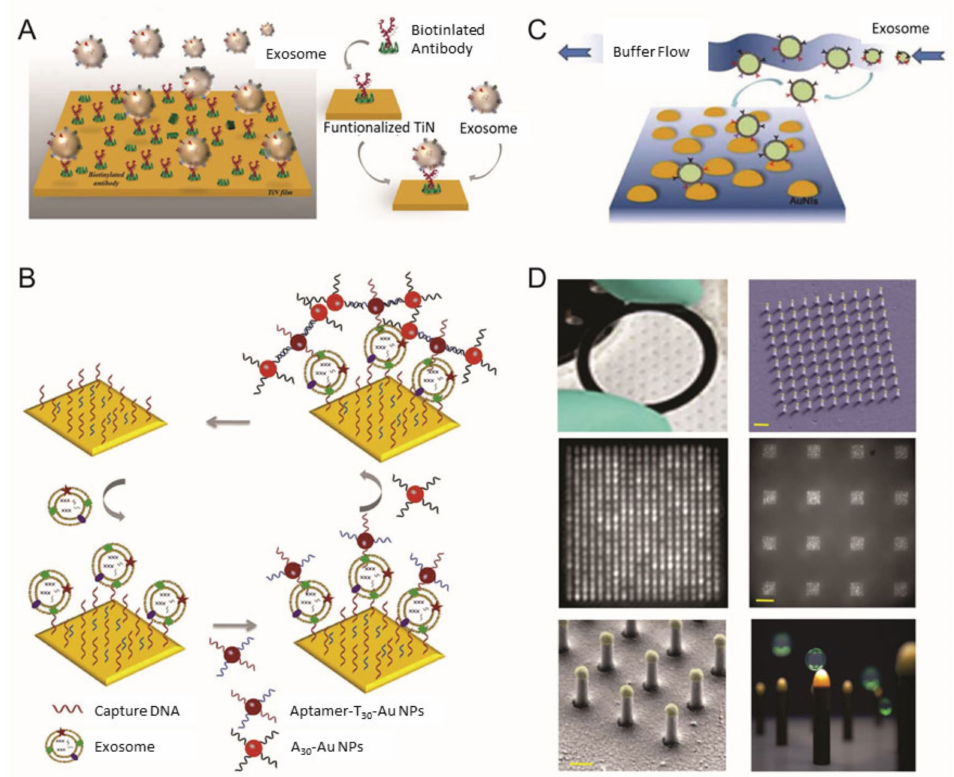
Figure 1. Surface plasmon resonance (SPR) biosensor for extracellular vesicles (EV) detection. ( A ) Schematic illustration of TiN nano-thick film functionalized by the anti-CD63 antibody for the detection of EVs; ( B ) dual Au Np-assisted signal amplification for the determination of EVs; ( C ) biophysical interaction of EV with self-assembled Au NIs without functionalization; ( D ) Au nanoplasmonic array functionalized with the anti-CD63 antibody for LSPR based digitalized detection of the EV. (reproduced with permission from [41] published by WILEY-VCH 2019, reproduced with permission from [42] published by Elsevier 2019, reproduced with permission from [43] published by Elsevier 2017 and reproduced with permission from [44] published by Public Library of Science